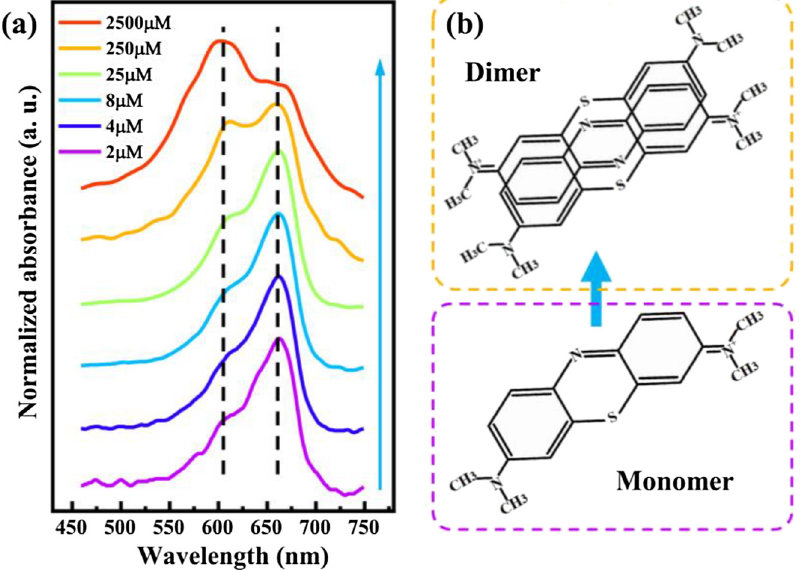
Figure 1: Absorption of MB monomer and dimer